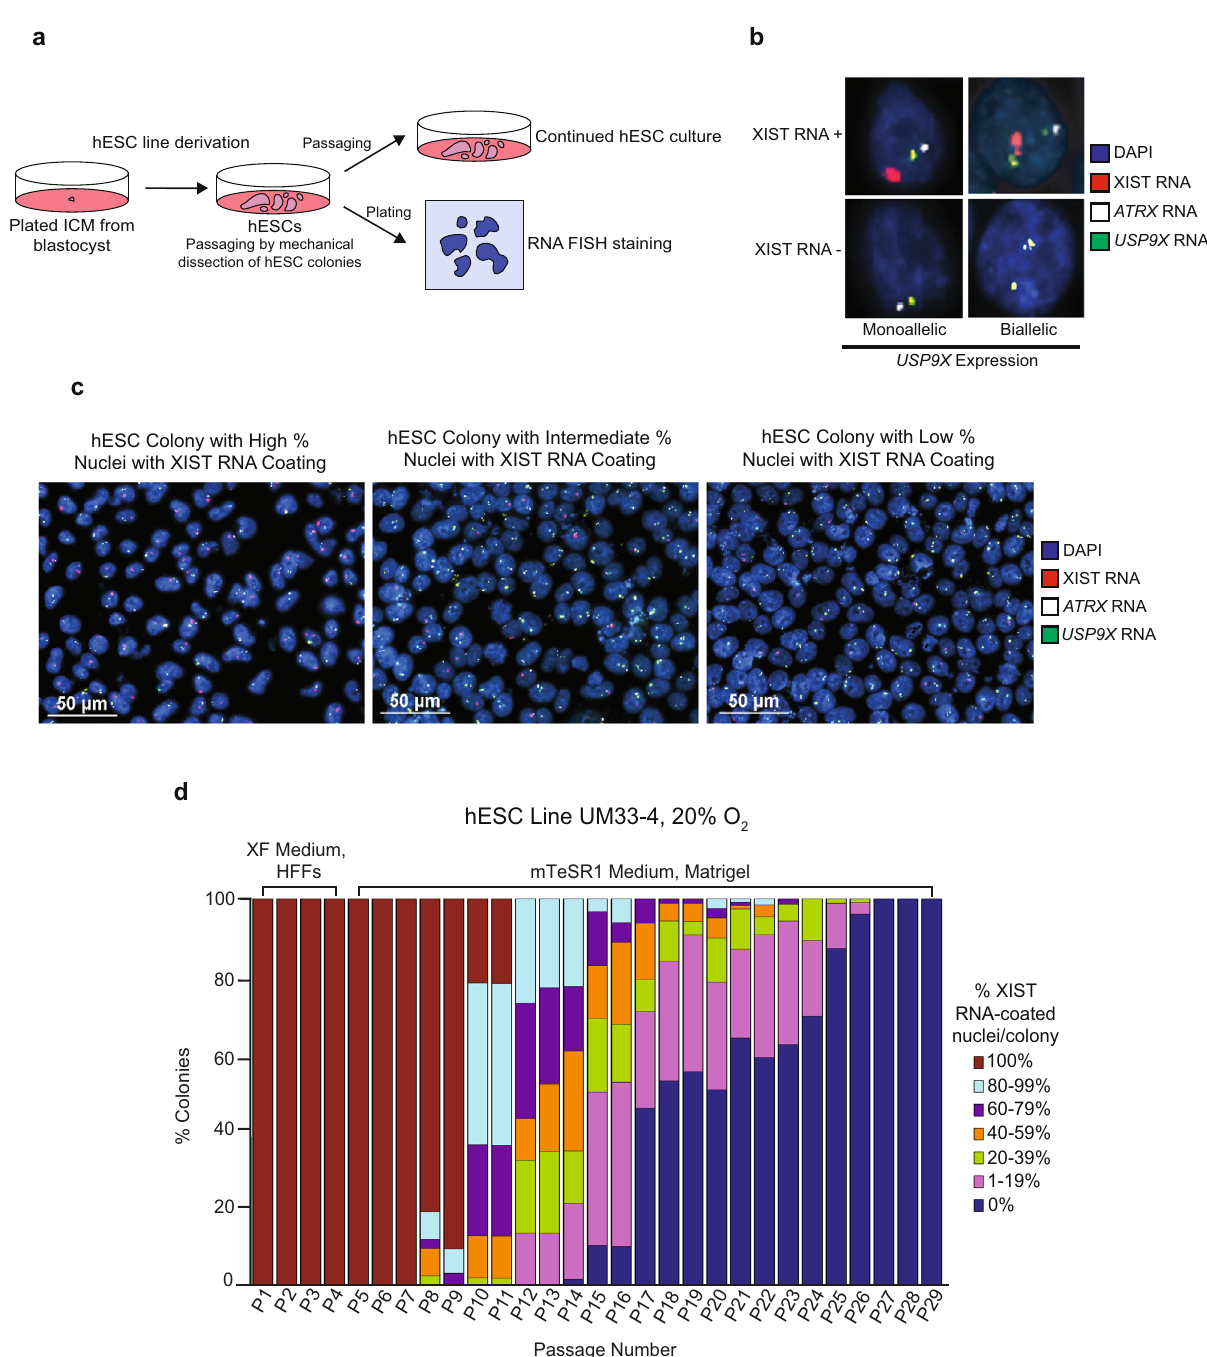
Fig. 1 Loss of XIST RNA coating upon prolonged passaging of female hESCs. a Schematic depicting the derivation, culture, passaging, and RNA FISH staining of hESCs in this study. b Representative nuclei stained to detect XIST RNA (red), RNAs from X-linked genes ATRX (white) and USP9X (green), and the nucleus with DAPI (blue). Top, representative nuclei with XIST RNA coating. Bottom, representative nuclei without XIST RNA coating. At least 100 nuclei were counted per colony for hESC RNA FISH quanti fi cation. The total number of colonies quanti fi ed at each passage range from 2 – 138 and are cataloged in source data. c Representative hESC colonies stained to detect XIST RNA (red), ATRX RNA (white), and USP9X RNA (green). Nuclei are stained blue with DAPI. At least 100 nuclei were counted per colony for hESC RNA FISH quanti fi cation. d Percentage of nuclei with XIST RNA coats per colony in hESC line UM33-4 derived in XenoFree (XF) medium on human fi broblast feeders (HFFs) and cultured subsequently on Matrigel under atmospheric oxygen levels (20%). The percentage of nuclei with XIST RNA coats in individual hESC colonies were strati fi ed into 20% increments. 100% value indicates that all nuclei in a colony harbored XIST RNA coats, whereas 0% indicates that all nuclei lacked XIST RNA coats in a colony. The percentage of colonies harboring nuclei with XIST RNA coats decreased signi fi cantly with passage number (general linear model, p = 0.002). See also Supplementary Fig. 2. Source data are provided as a Source Data fi